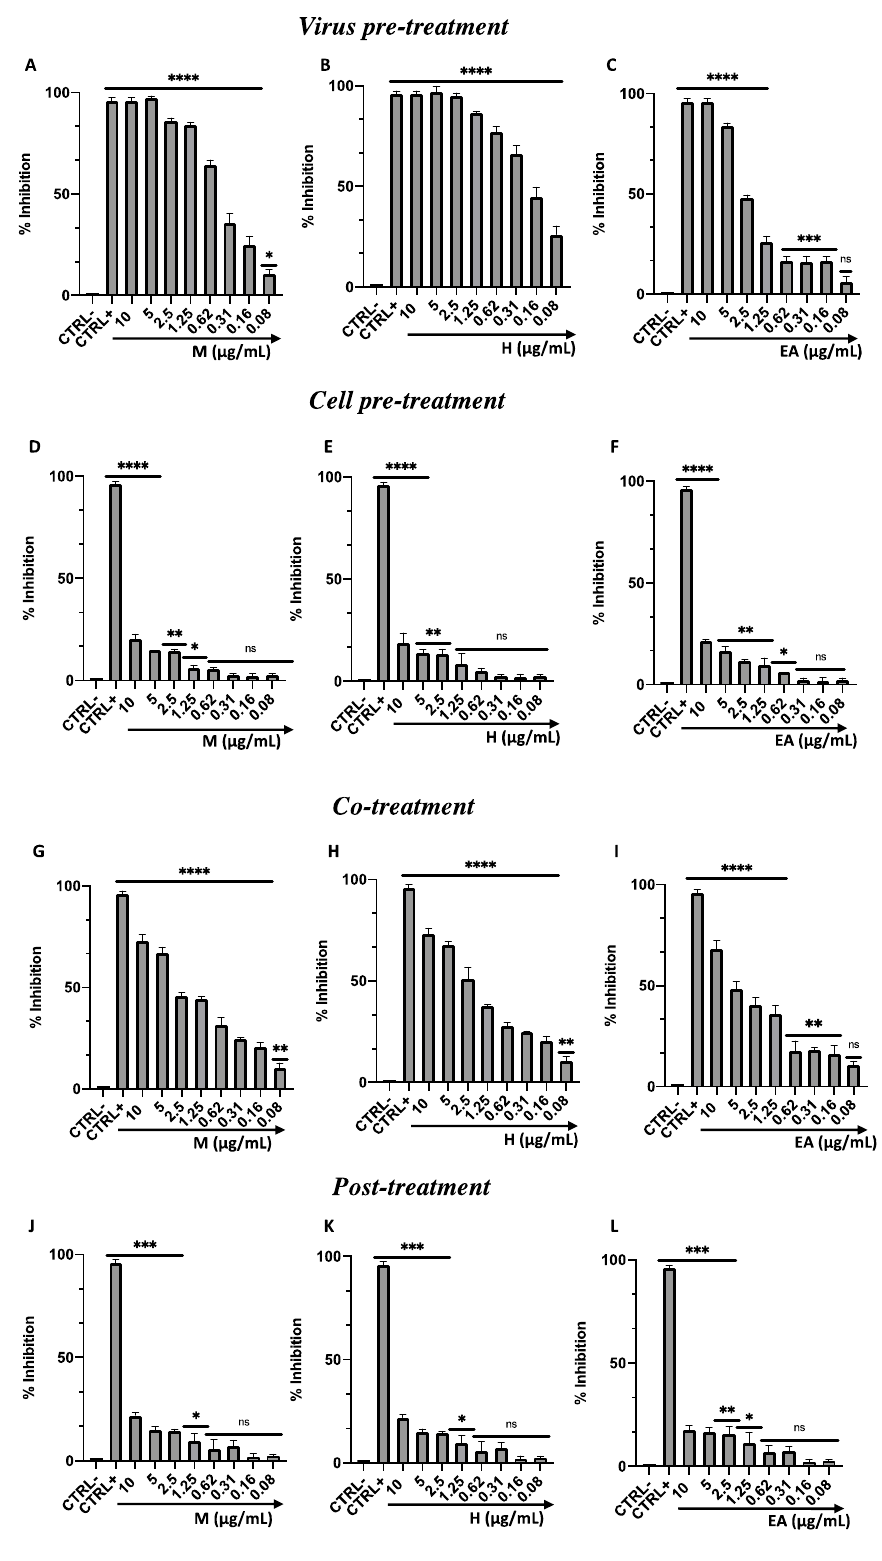
Figure 4. Antiviral activity of M, H, and EA from F. rubiginosa L. extract against HCoV-229E. Four plaque reduction assays were performed: ( A – C ) virus pretreatment assay; ( D – F ) cell pretreatment assay; ( G – I ) co-treatment assay; ( J – L ) post-treatment assay. Data represent mean ± standard deviation (SD) of three independent experiments. ****: p -value < 0.0001; ***: p -value < 0.0007; **: p -value < 0.008; *: p -value < 0.04; ns: not significant.